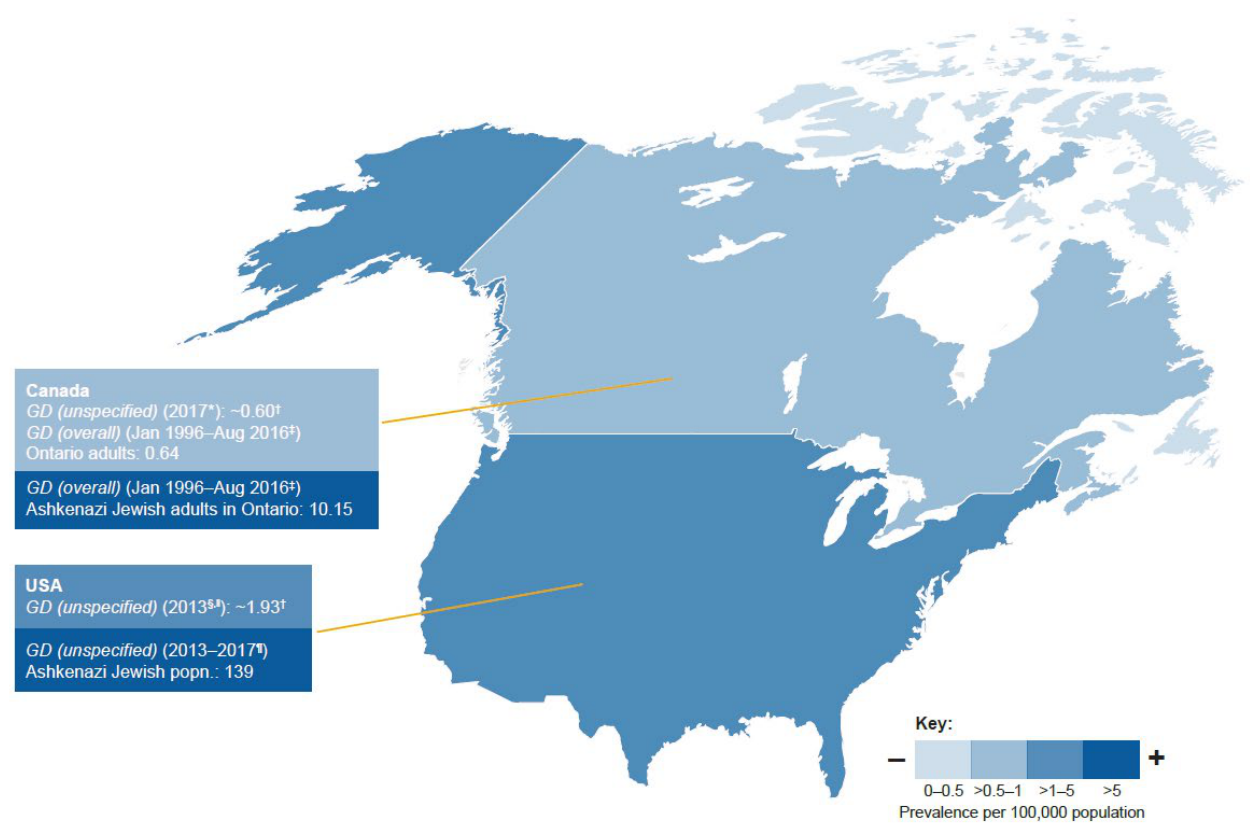
Figure 4. Prevalence estimates for GD: North America. GD unspecified refers to absence of any mention of whether study targeted GD overall or a given type. * Source: Cerdelga ® notice of refusal in Quebec population in 2017 [51]. † Estimates were calculated using the country population size during the study period. ‡ Retrospective cohort study in adult Ontario population in 2016 [43]. § Estimates were calculated using the reported prevalence and distribution of GD types. (cid:107) Source: Physician’s guide to Gaucher Disease from NORD US population in 2013 [50]. ¶ Prospective cohort of Ashkenazi Jewish students participating in an at-home national Jewish genetic disease screening initiative [40].